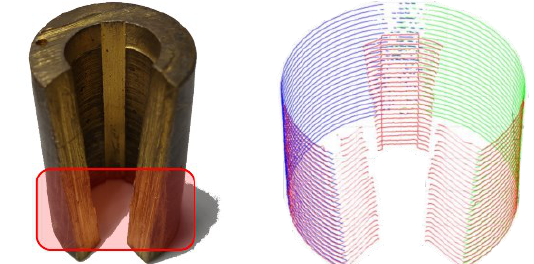
Figure 18: 25 mm diameter hollow brass cylinder with diagonal cut – 25 sections with 0.68 mm between